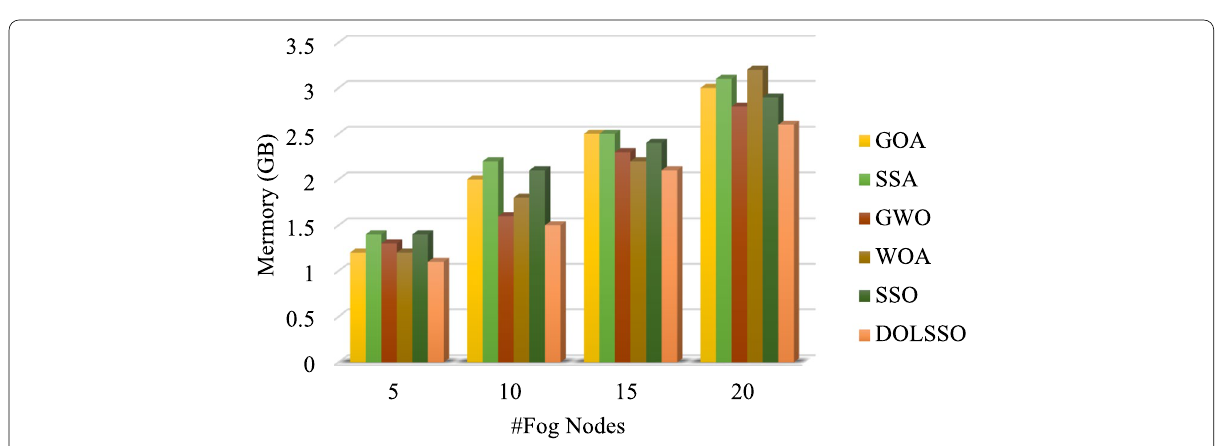
Fig. 6 Analysis and comparison of Allocated memory for the